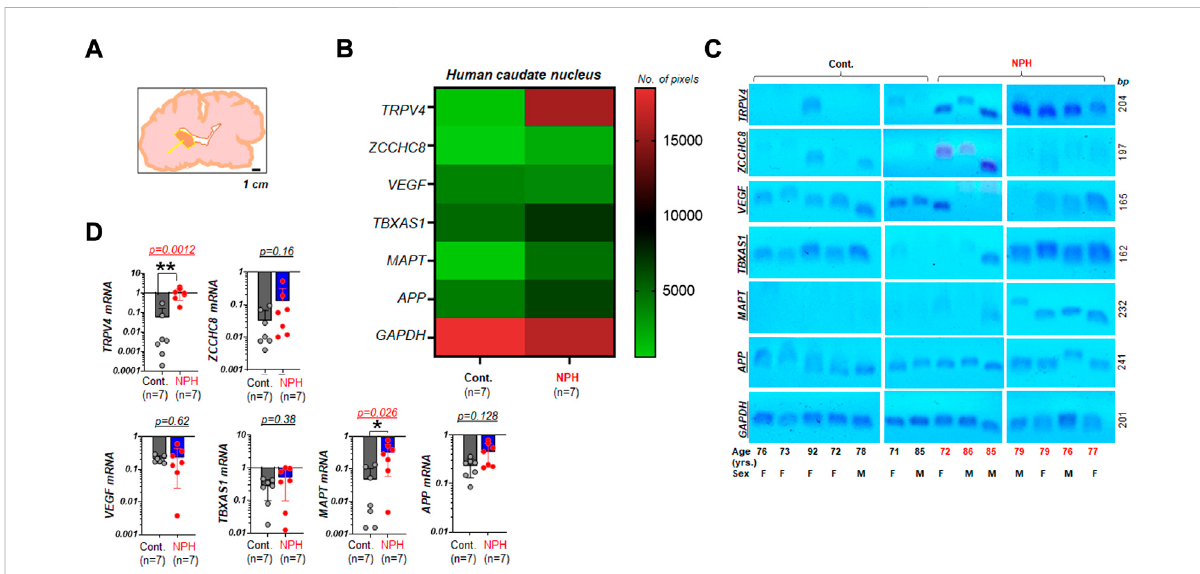
FIGURE 1 Elevated TRPV4 mRNA in the caudate nucleus with NPH (A) A simpli fi ed illustration indicating the neuroanatomical location where human postmortem tissue was harvested for assays (arrow: the caudate nucleus). The illustration was redrawn following the photograph taken at one of NeuroBioBank (NBB) tissue repositories. Scale bar, 1 cm (B) a color-coded map illustrating the summary of the assay result on expression levels of TRPV4andothergenesassociatedwithNPHinthecaudatenucleusofhumanswithunaffectedcontrol(Cont.)andNPH,respectively.Notethat 6genesofinterestand1housekeepinggene(GAPDH)weremarkedontheleft y axis.ThenumberofpixelsfromImageJwithcodedcolorwasshown on theright. n = 7per group. (C) Agarosegels displaying mRNA expressions ofTRPV4, ZCCHC8, VEGF, TBXAS1,MAPT, and APP relativeto GAPDH in the caudate nucleus of aged human postmortem brains classi fi ed as Cont. (n = 7) and NPH (n = 7). yrs., years (D) bar graphs with scatter plots summarizingmRNA expressions of select genes relative to GAPDH in NPH (n =7) as comparedto those of unaffected controls (n = 7).**, p < 0.01; *, p < 0.05 by Mann-Whitney